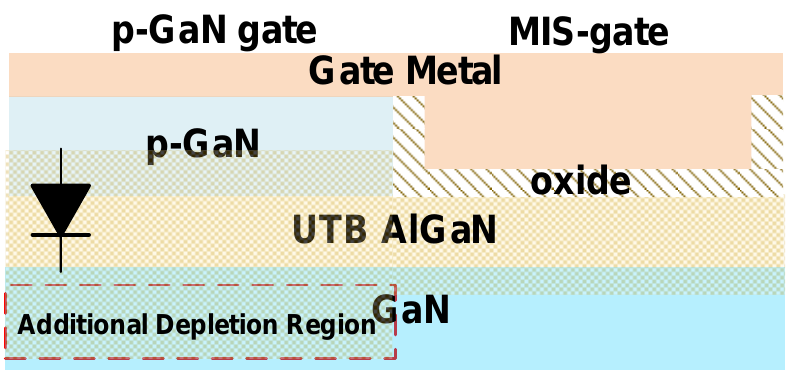
Figure 1. Schematic cross-sectional structure of the HG-UTB HEMTs.